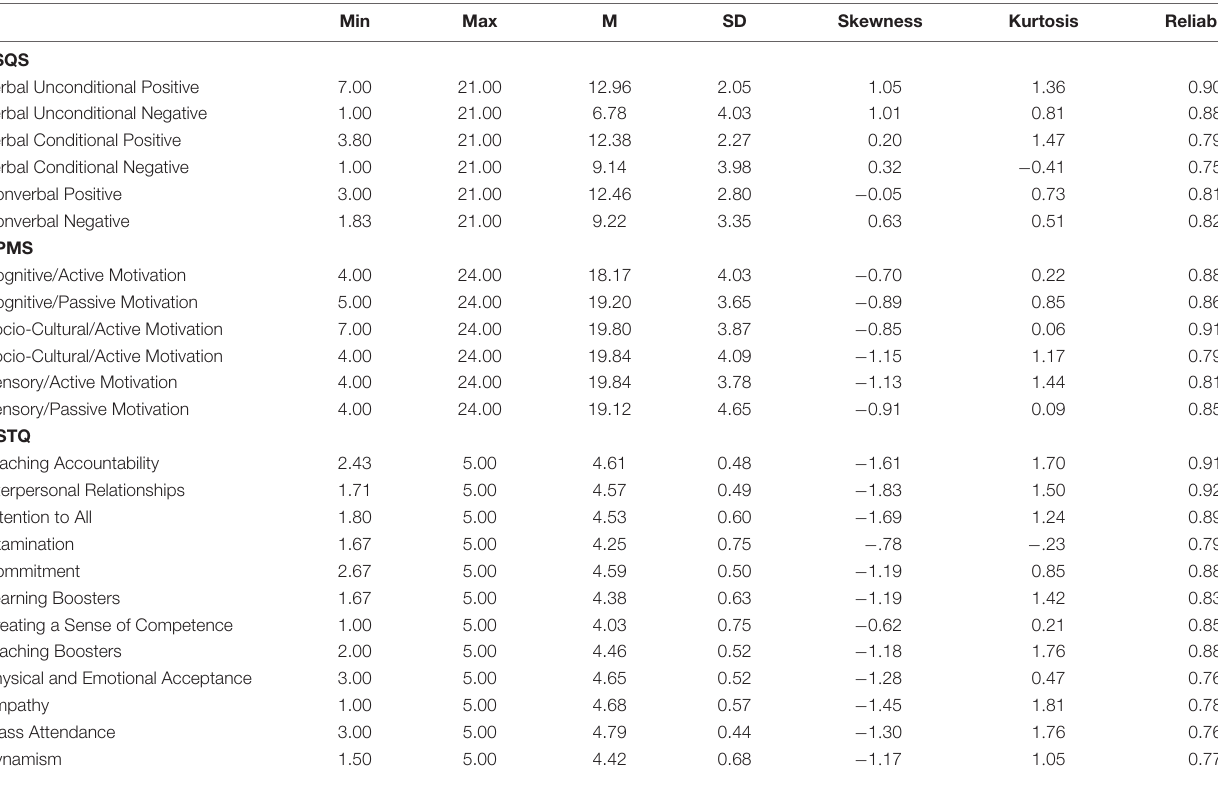
TABLE 1 | Descriptive Statistics and Reliability Estimates for LSQS, APMS, and CSTQ.